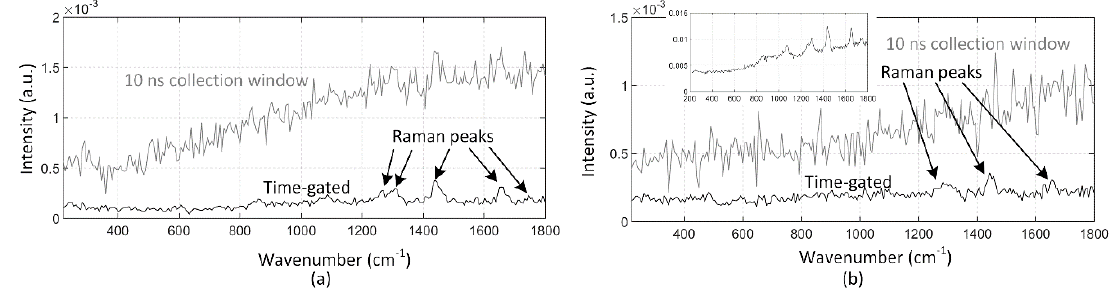
Figure 10. Raman spectra of olive oil measured by gating the bins of the TDC to collect photons from the target and collecting photons within a 10 ns collection window at distances of ( a ) 30 cm and ( b ) 50 cm with the normal laboratory lights on.